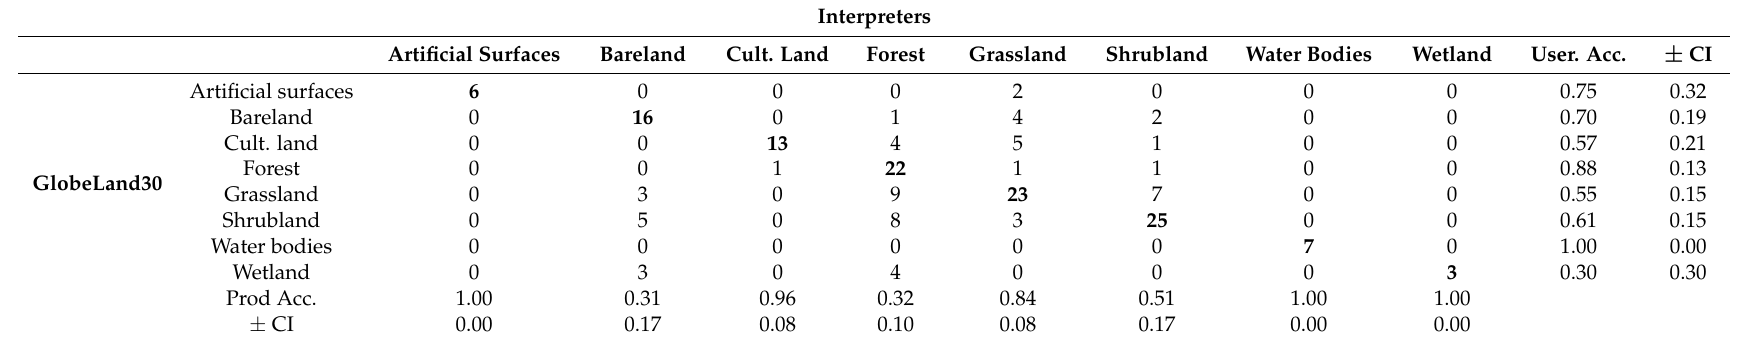
Table 4. Confusion matrix for Sample 1 ( n = 179) using results that allow for multiple classes when Landsat or other similar resolution imagery is only available for confusion